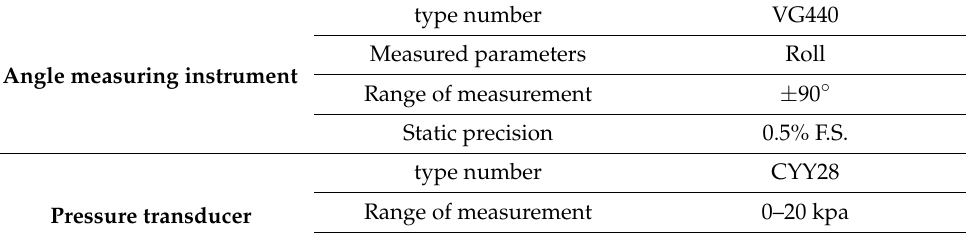
Table 2. The properties of the measuring equipment.